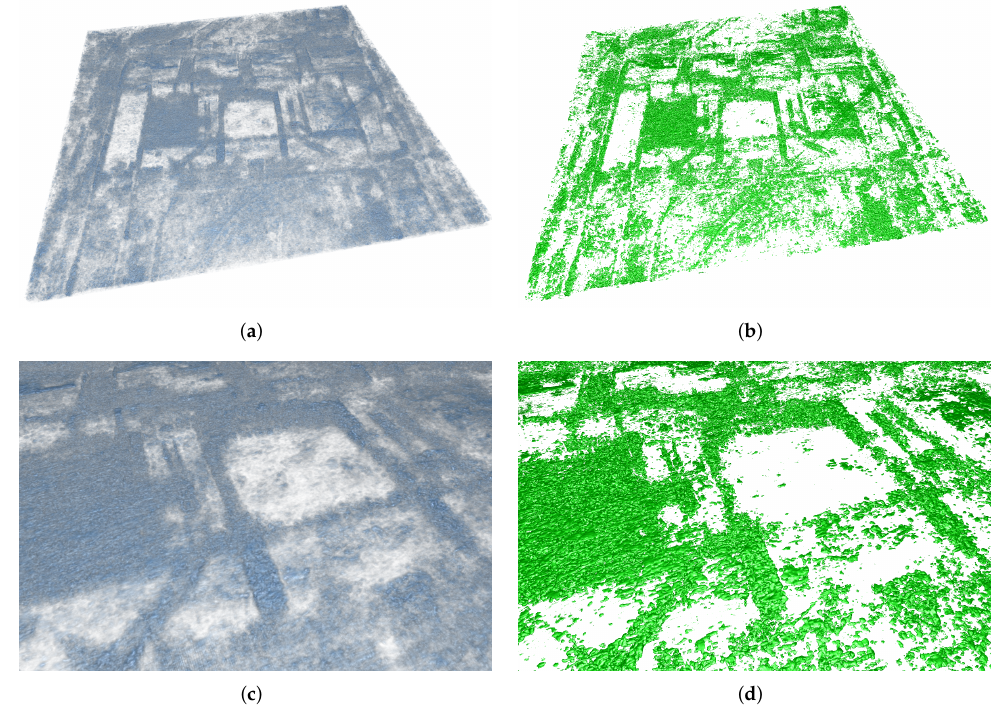
Figure 4. Direct volume visualization and iso-surface visualization of unfiltered GPR dataset: The structures visible in individual 2D slices can also be seen in the 3D DVR images ( a , c ). The moderate gain in plasticity for walls is paid for with a high degree of clutter caused by ground structures sharing the same dataset values. Iso-surface visualization avoids the blurring caused by blending semi-transparent soil structure contributions. Still, the walls are only visualized as accumulations of strong radar reflectors like individual bricks or stones, rather than independent superordinate structures ( b , d